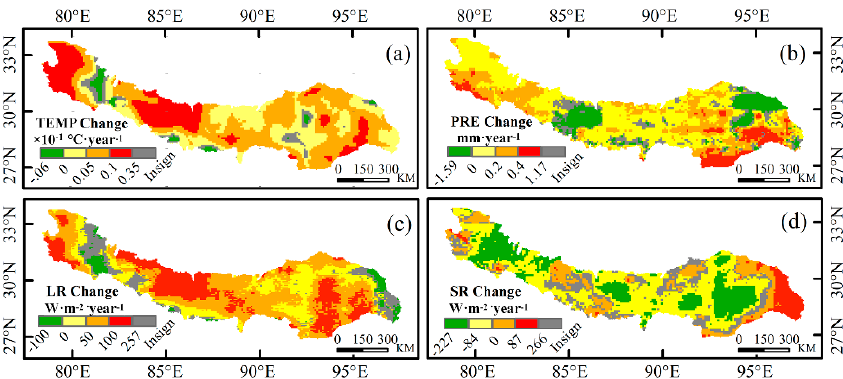
Figure 3. Spatial pattern of interannual NDVI trends at a pixel scale from 1982 to 2015.